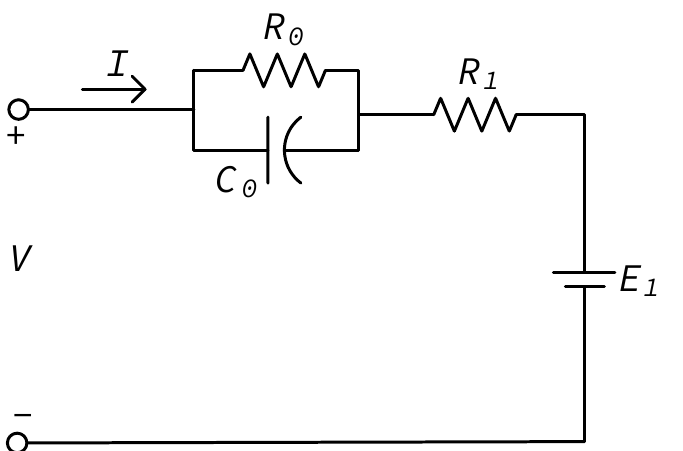
Table 1. EMG-BES cell model parameters.